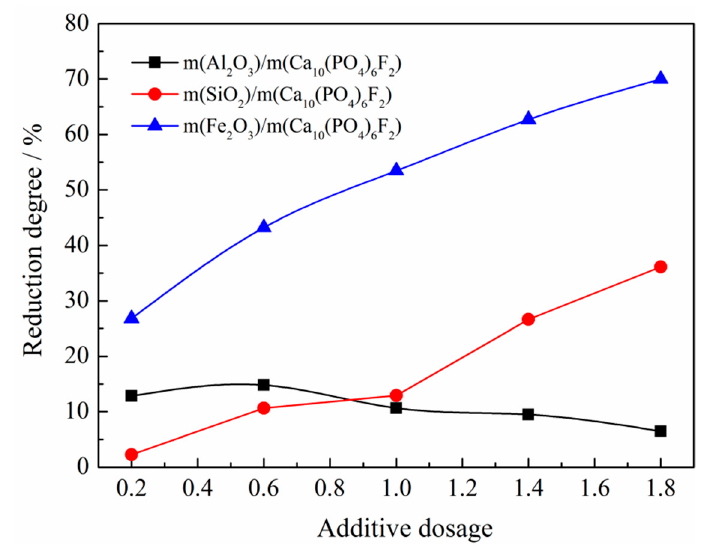
Figure 6. Effect of additive contents on the reduction degree of fluorapatite. Figure 6. E ff ect of additive contents on the reduction degree of